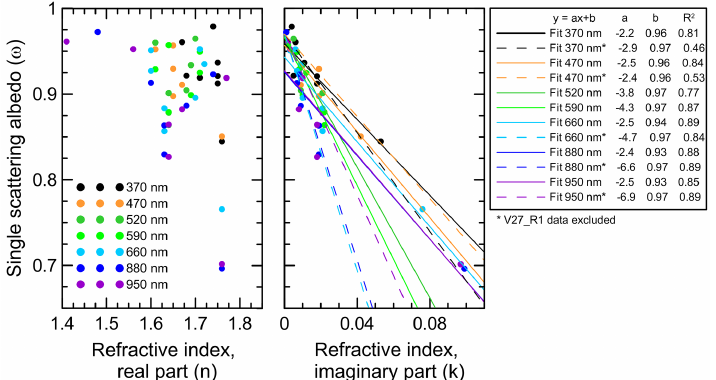
Figure 9. Spectral single scattering albedo plotted against the real (left panel) and the imaginary (right panel) parts of the complex refractive index. The results of the linear fit between ω and k are reported in the legend. The fits are performed for the whole ω - k data set, and also eliminating the data in correspondence of V27_R1, for which the largest values of k were observed.